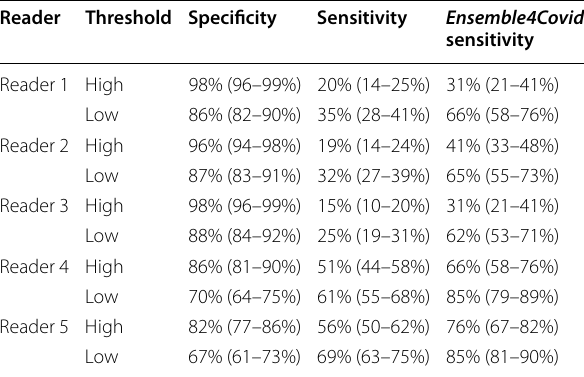
The sensitivity of the Ensemble4Covid model for the same mean specificity is also displayed. Values in parenthesis are 95% confidence intervals